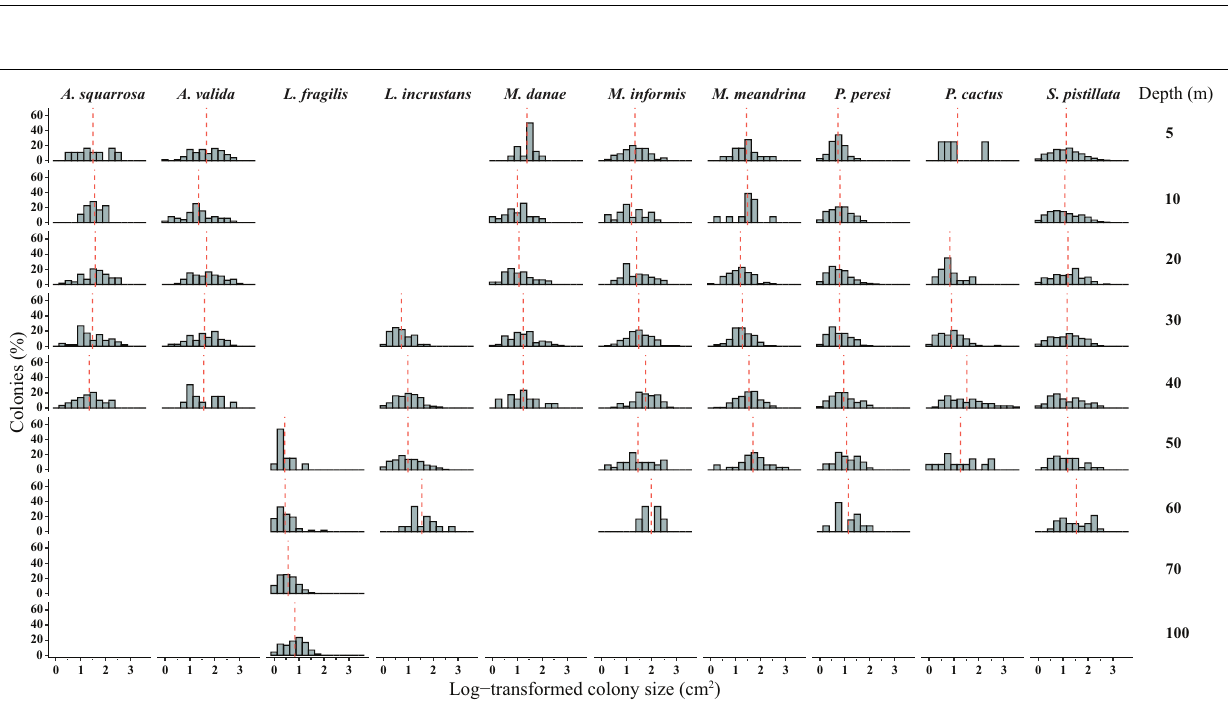
FIGURE 4 | Size-frequency distributions (SFDs) based on log-transformed size classes of ten representative locally abundant species: A. squarrosa , A. valida , L. fragilis , L. incrustans , M. danae, M. informis, M. meandrina, P. peresi, P. cactus, and S. pistillata across depths (5, 10, 20, 30, 40, 50, 60, 70, and 100 m; pooled among sites). Dashed orange lines indicate mean log